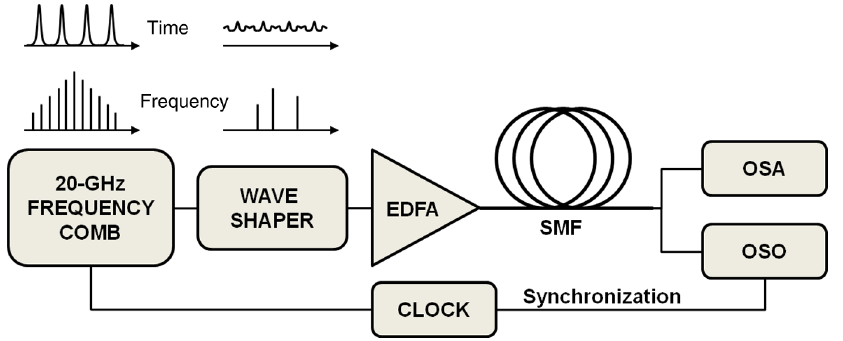
FIG. 5. Experimental